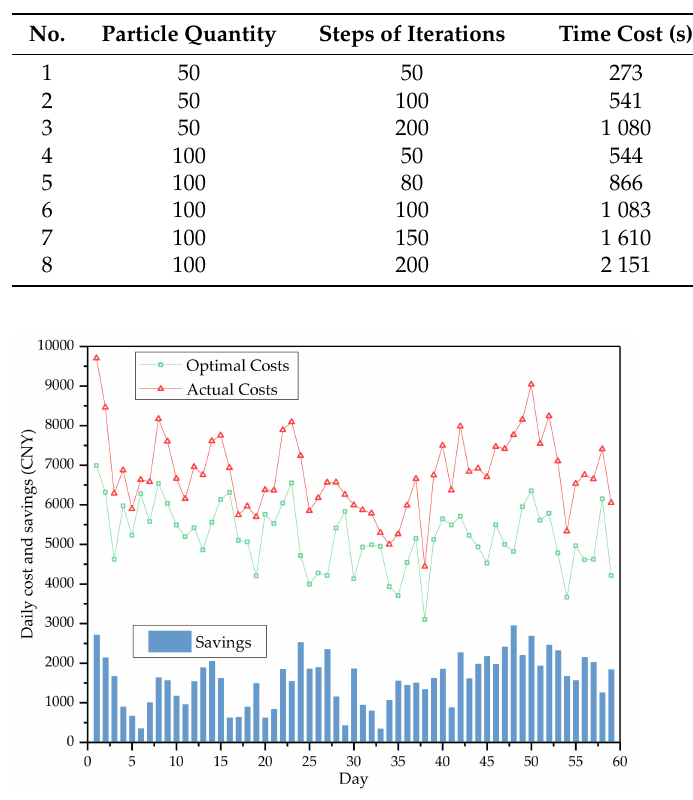
Figure 4. Comparison between the daily actual costs, optimal costs, and savings of the case system for 59 d from 22 June to 19 August